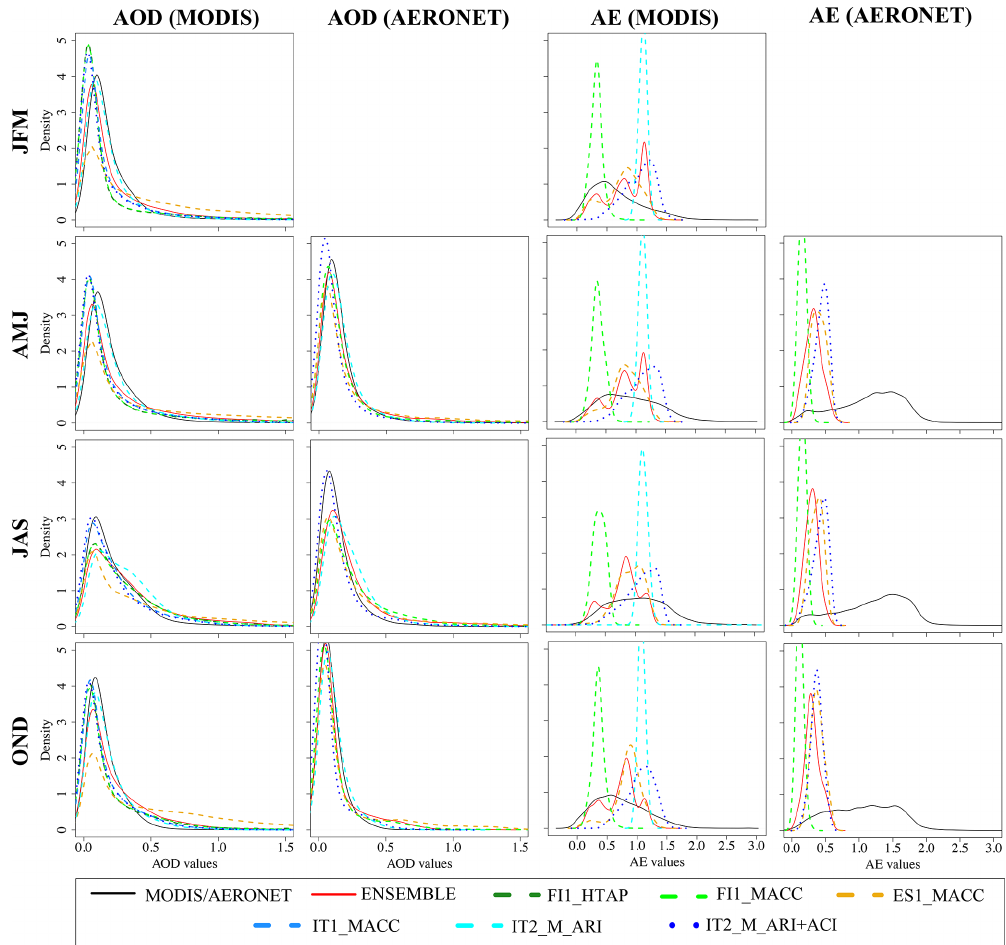
Figure 8. PDFs for AOD (first, MODIS and second, AERONET columns) and AE (third, MODIS and fourth right, AERONET) values. From the top to the bottom: JFM, AMJ, JAS,